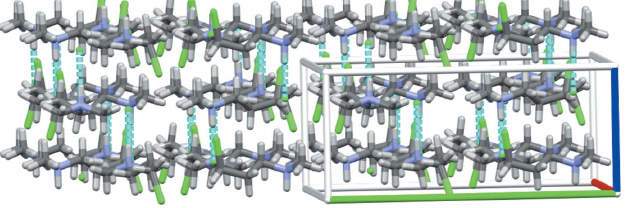
Figure 6 Capped-stick packing diagram for the title compound showing the sequential offset stacking of three layers and the interlayer hydrogen bonding that connects neighboring